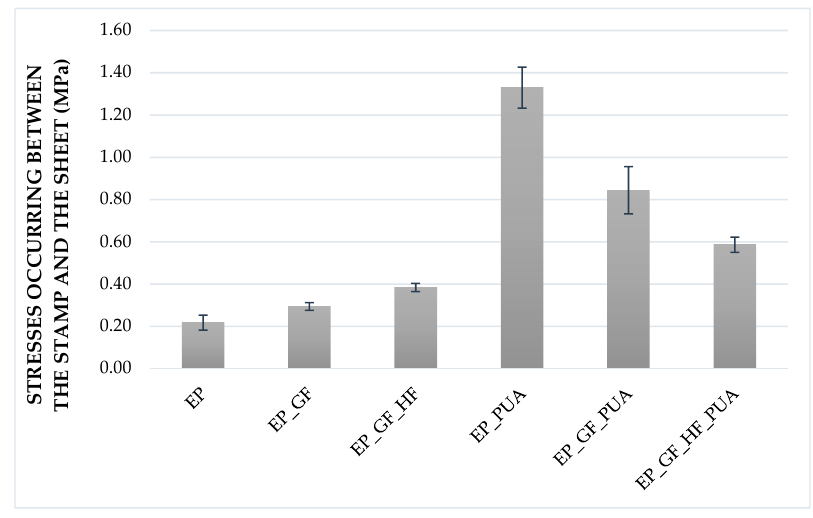
Figure 4. Pull-off force values obtained in the PosiTest test for all types of coating.